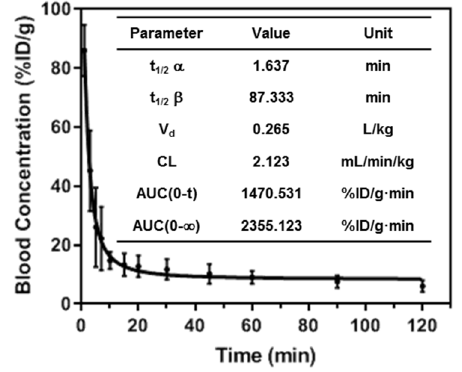
Figure 3. The drug concentration–time profiles and pharmacokinetic parameters of [ 18 F] LP-F in normal mice ( n = 3) within 2 h.